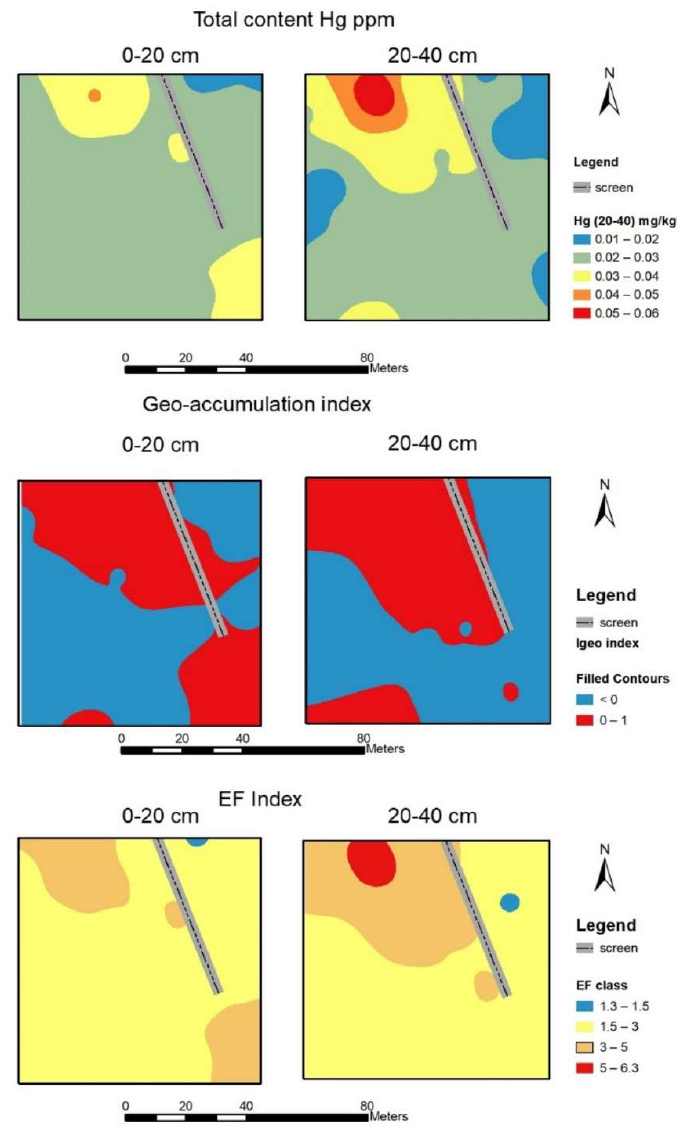
Figure 3. Spatial distribution of Hg and geo-accumulation index and EF Index.